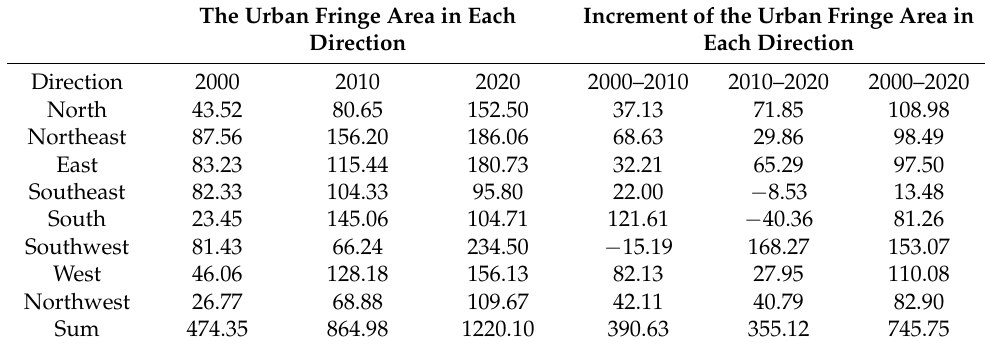
Table 8. Area of geographical spatial structure within administrative districts of Wuhan City, 2000– 2020 (km 2 ).